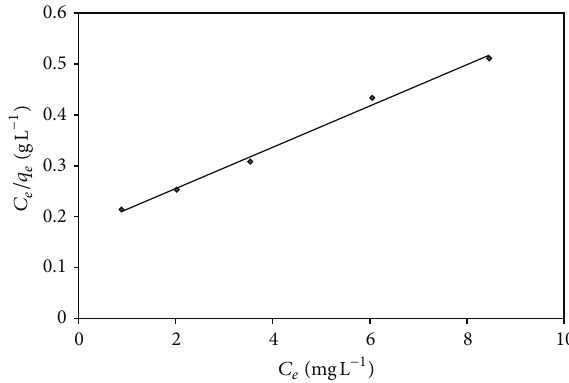
Figure 6: Effect of pH on the adsorption of RhB onto NSCSH.